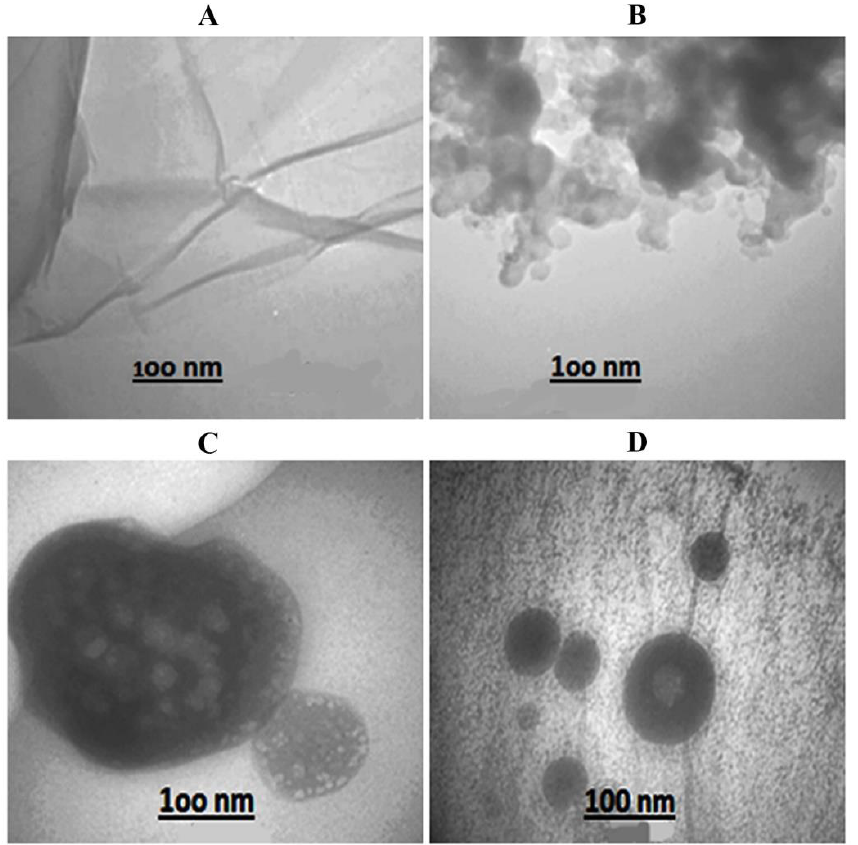
Figure 3. TEM images of ( A ): GONPs, ( B ): GONPs-PEG, ( C ): N. sativa and ( D ): GONPs-PEG- N. sativa .